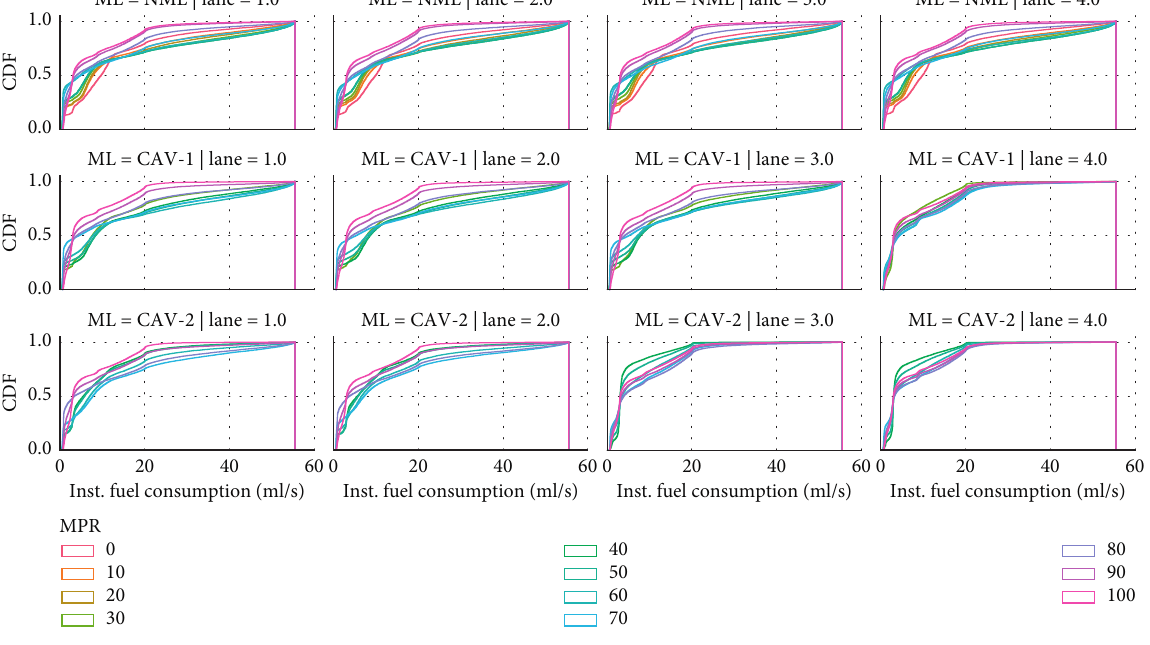
Figure 7: Instantaneous fuel consumption for all vehicles.